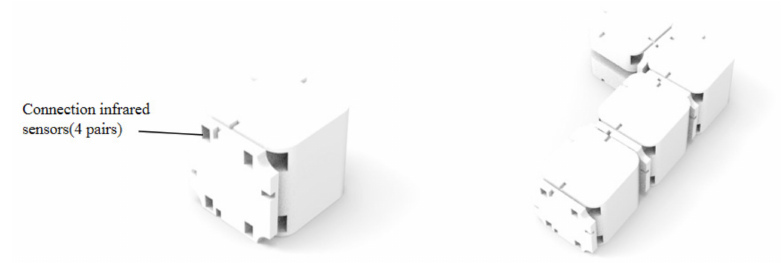
Figure 4. Sambot modular robot.